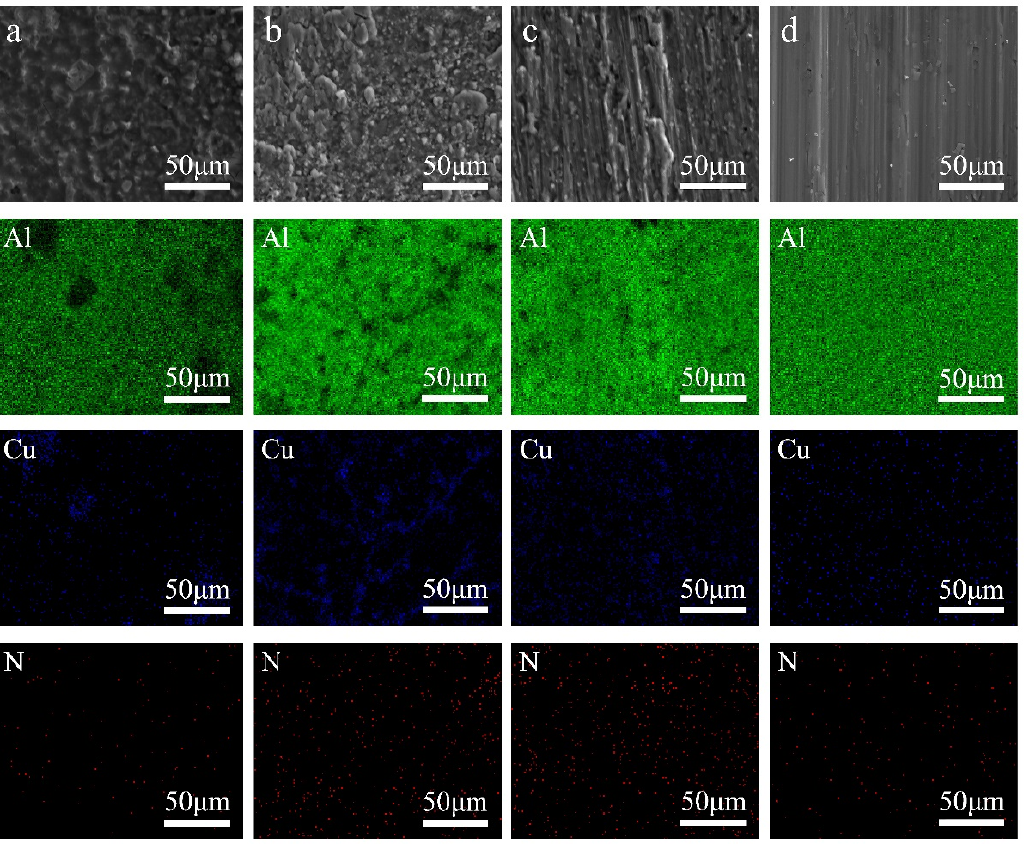
Figure 8. SEM images of shear fracture and scanning results of Al, Cu and N elements of brazed joints at different temperatures. ( a ) 600 °C; ( b ) 620 °C; ( c ) 640 °C; ( d ) 660 °C.